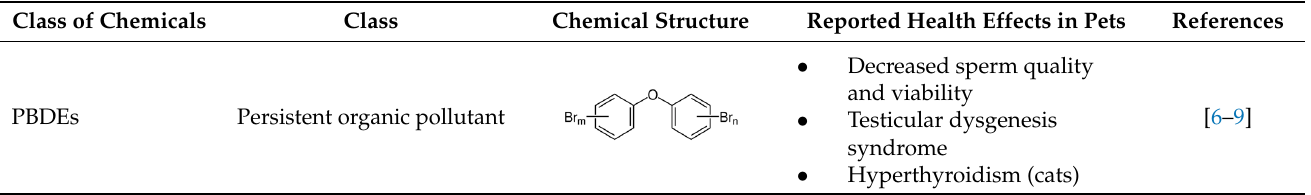
Table 1. Class, chemical structure, common uses, and health effects of EDCs in domestic pets.